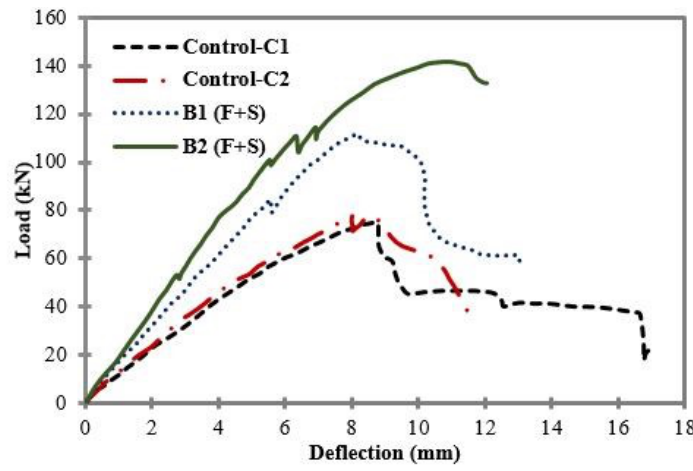
Figure 6. Load vs. mid-span deflection for Control samples C1 and C2, B1 and B2.